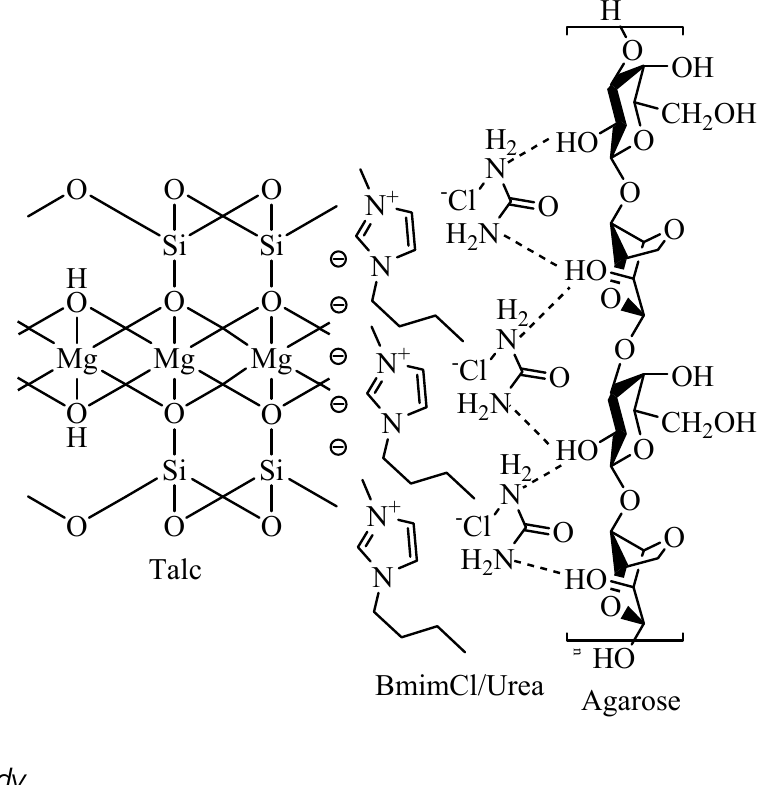
Figure 8. Proposed interactional model for the talc–BmimCl/Urea–agarose in the composite